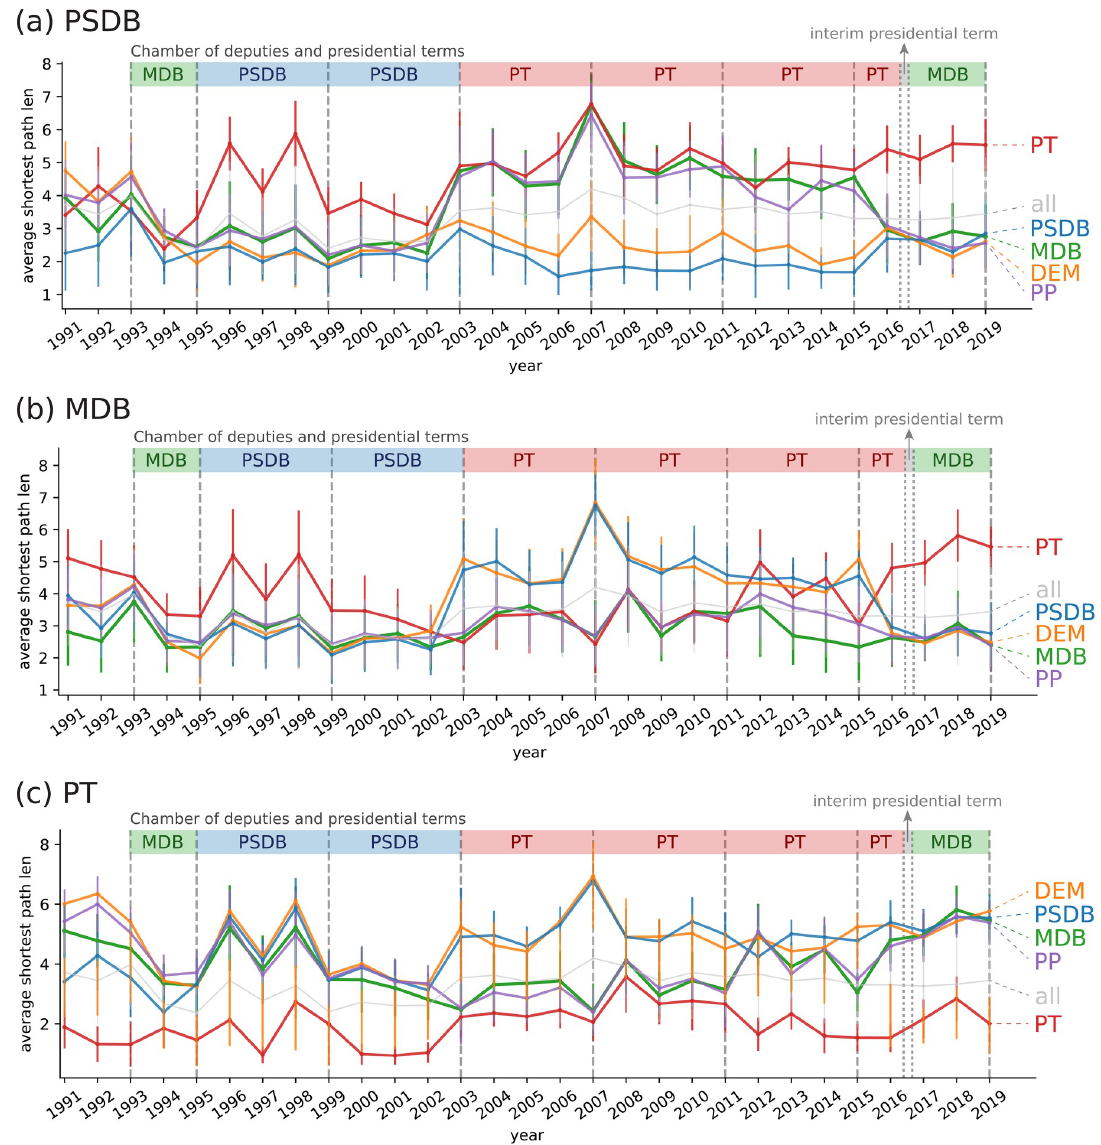
Fig 10. Average shortest path length between (a) PSDB, (b) MDB and (c) PT deputies to other parties. Distances are computed using Eq 8. The fragmentation (e.g. d (PSDB, PSDB)) is computed using Eq 12. Presidential terms are highlight in the period between 1993 and the end of